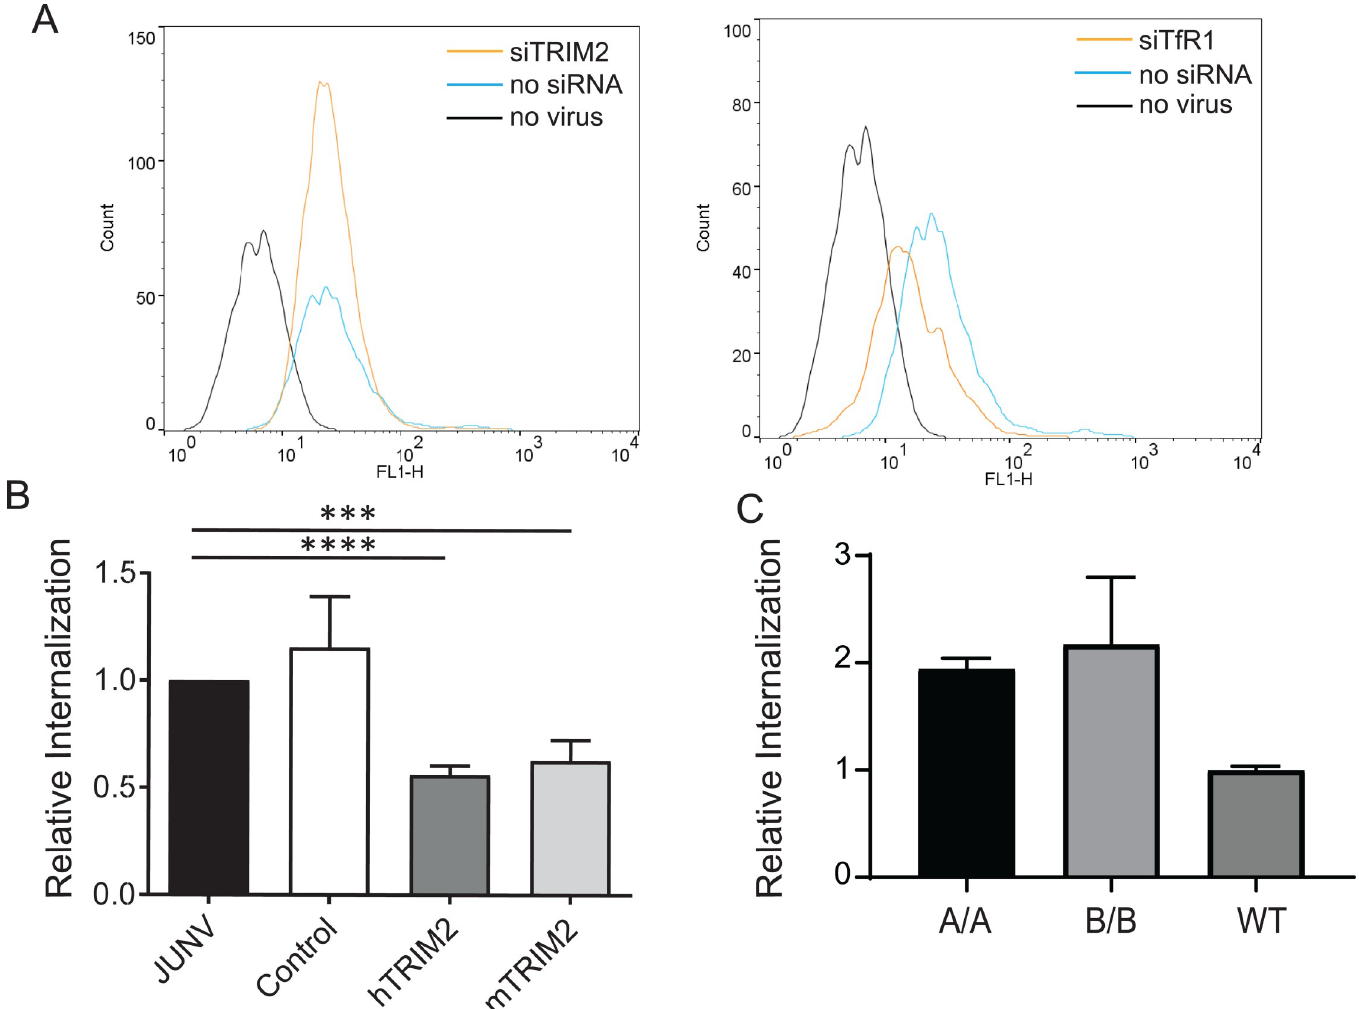
Fig 4. TRIM2 decreases JUNV entry into cells. (A) TRIM2 knockdown does not affect virus binding to cells. U2OS cells were transfected with a TRIM2 siRNA and incubated with FITC-labeled Candid 1. Shown is a representative FACS plot. This experiment was performed twice with similar results. (B) Cells overexpressing hTRIM2 or mTRIM2 or GFP (Control) were incubated with Candid 1, and after a 1-hr incubation at 37˚C, virus was stripped from cells, and RNA was isolated and analyzed for viral RNA by RT-qPCR. Shown are the averages ± SD of 6 independent experiments. P values were determined by unpaired t tests; ��� P � 0.0002; ���� P � 0.0001. See also S4 Fig. (C) The same experiment was performed with primary bone marrow–derived macrophages isolated from mice of the indicated genotype. Values represent the mean ± SD in 2 independent experiments with triplicate experimental replicates. FACS, fluorescence-activated cell sorting; FITC, fluorescein isothiocyanate; GFP, green fluorescent protein; hTRIM2, human TRIM2; JUNV, Junı´n virus; mTRIM2, mouse TRIM2; RT-qPCR, real-time quantitative PCR; siRNA, small interfering RNA; TfR1, transferrin receptor 1; WT, wild type.